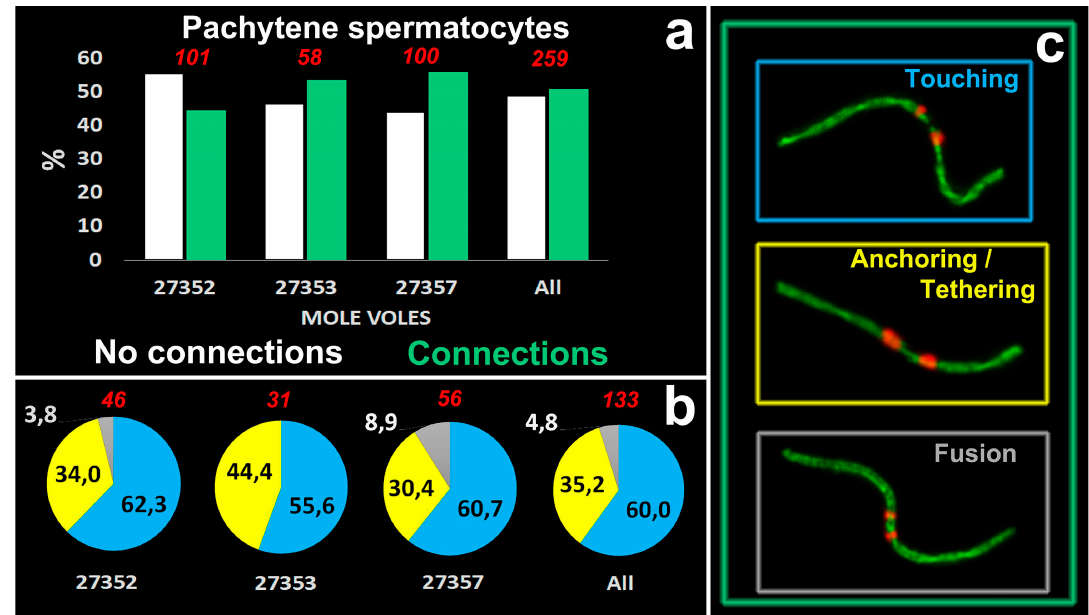
Figure 5. Quantitative characteristics of meiotic contacts in E. alaicus . a. The diagram shows the percentage of pachytene cells with or without meiotic connections in three mole vole males ( № 27352, 27353, 27357). ‘Touching’, ‘anchoring/tethering’ and ‘fusion’ types were counted in cells with connections only. b. Proportions of connection types. Blue color corresponds to ‘touching’, yellow—to ‘anchoring/tethering’ and gray—to ‘'fusion’'. Red numbers are counted pachytene spermatocytes ( a , b ). c. Types of contacts that are included in the diagrams. The color of the frames corresponds to the types of contacts ( b